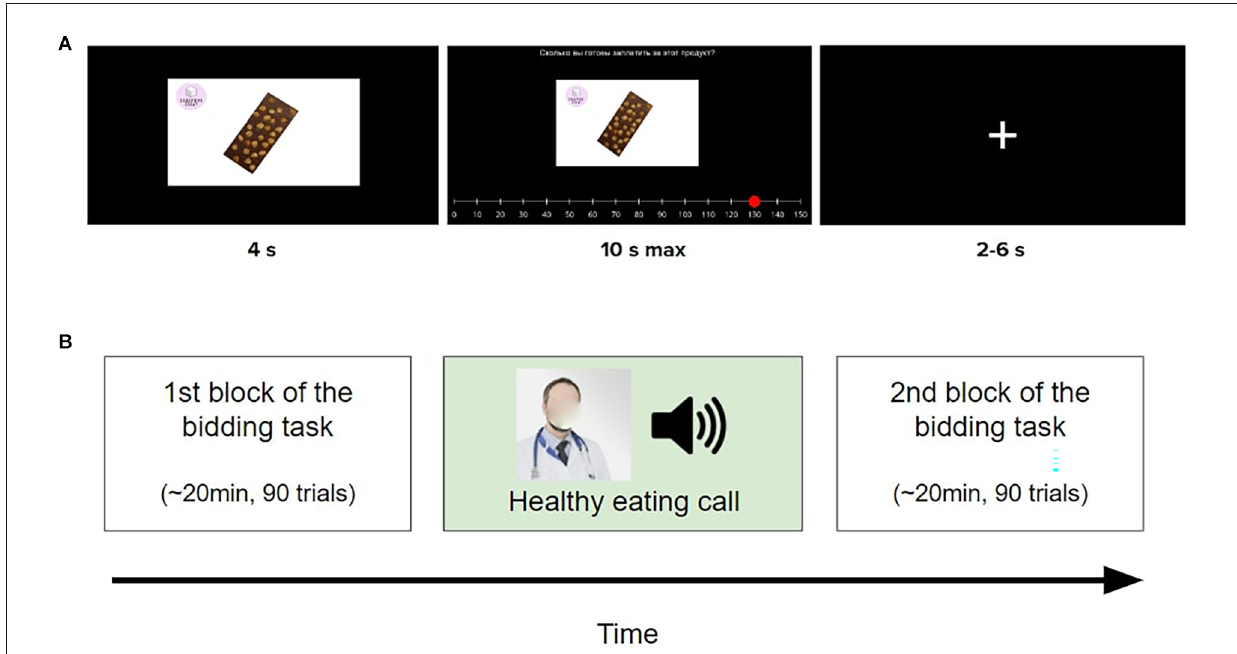
FIGURE1 Trial structure and study design. (A) Sample trial of the bidding task with a product labeled as “sugar-containing”. In the beginning, the product was presented for 4 s (“early evaluation phase”). Next, a message was displayed at the top of the screen “How much are you ready to pay for this product?”. Participants had 10 s to indicate their willingness to pay (WTP) for this product. Last, a fixation cross was shown (2–6 s) and the next trial began. The trials of the other two conditions differed only in the label and in the presented product. (B) Experimental procedure. Participants first performed